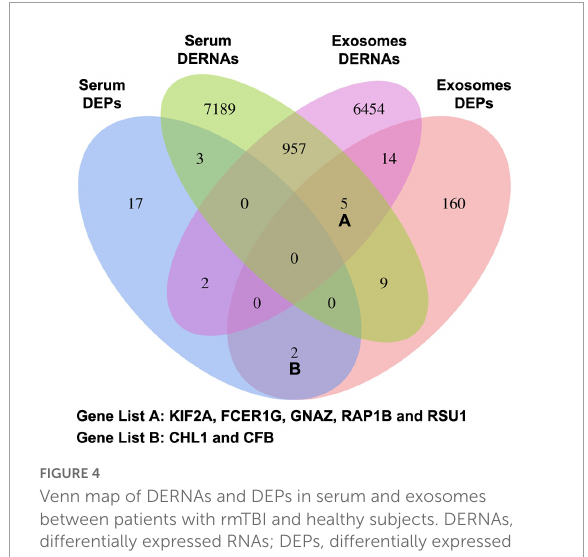
FIGURE4 Venn map of DERNAs and DEPs in serum and exosomes between patients with rmTBI and healthy subjects. DERNAs, differentially expressed RNAs; DEPs, differentially expressed